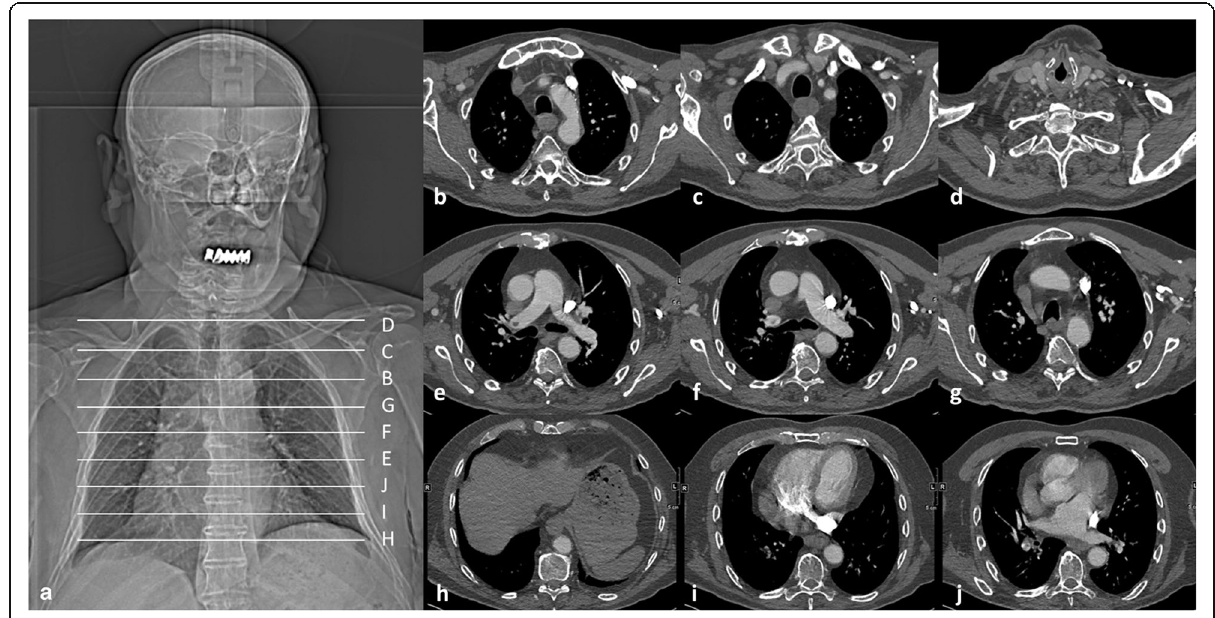
Fig. 1 Examples of anatomical landmarks on axial CT angiography source images. a Shows a topogram of a CT angiography with reference lines corresponding to anatomical landmarks depicted in ( b - j ). Axial CT angiography images at the level of the aortic arch ( b ), supra-aortic vessels ( c ), cervical arteries ( d ), main pulmonary artery ( e ), carina ( f ) and ascending aorta (above the carina ( g ). The diaphragm and abdominal organs are shown in ( h ), the ventricles and left atrium in ( i ) and ( j ). Note: Depending on the level of the most caudal axial image the following lung segments are usually, at least partially, covered by CT angiography: B = right: 1 – 3, left: 1 + 2 and 3; C = right: 1 and 2, left: 1 + 2; D = no lung tissue; E = right: 1 – 3 and 6, left: 1 + 2, 3, 4 and 6; F = right: 1 – 3 and 6, left: 1 + 2, 3 and 6; G = right: 1 – 3, left: 1 + 2, and 3; H = right: 1 – 10, left: 1 – 10; I = right: 1 – 10, left: 1 – 10; J = right: 1 – 6, left: 1 – 6, and 8